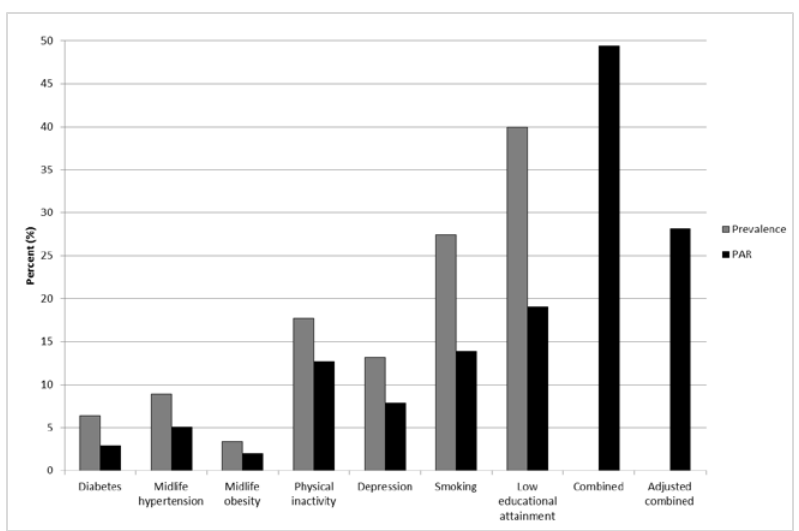
Figure 1: Prevalence and estimates for population-attributable risks for Alzheimer’s disease in 2010. Data source: Norton et al. [11]. PAR = population-attributable risk, the proportion of Alzheimer’s disease cases in the population that can be attributed to individual risk factors calculated by using the population prevalence and the relative risk of the risk factor. Combined = calculated prevalence and PAR for the seven individual risk factors combined, assuming independence of the risk factors. Adjusted combined = calculated prevalence and PAR for all seven risk factors combined with adjustment for non- independence of the risk